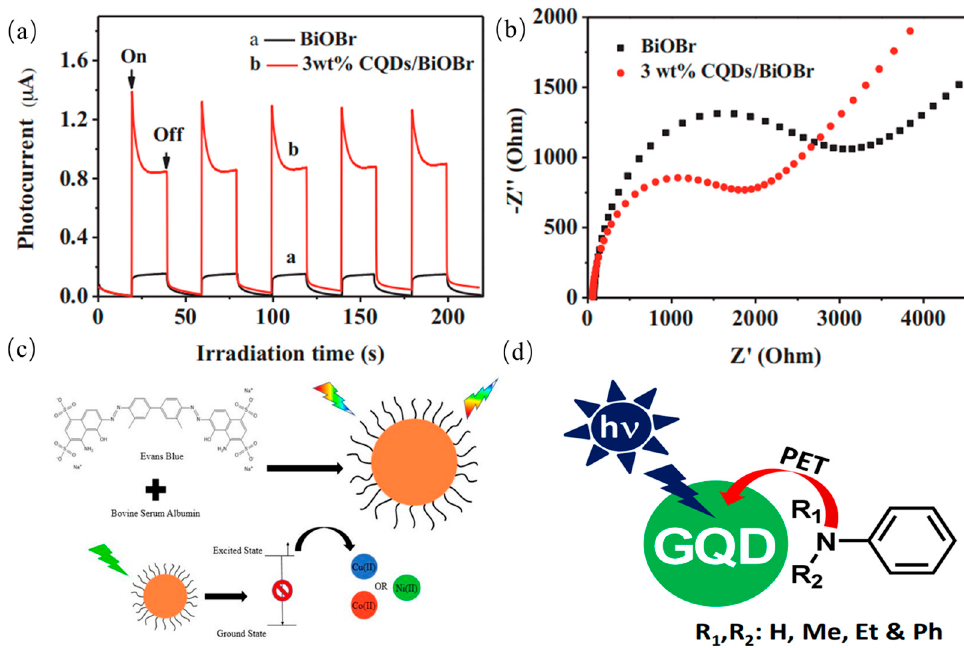
Figure 16. Transient photocurrent response ( a ) and electrochemical impedance spectra ( b ) of pure BiOBr and the CQDs/BiOBr composite [138]. Copyright 2016, Elsevier. ( c ) The PET process between amine functional groups and metal ions interacted [139]. Copyright 2018, American Chemical Society. ( d ) The PET processes between GQDs and various aniline derivatives [140]. Copyright 2015, American Chemical Society.